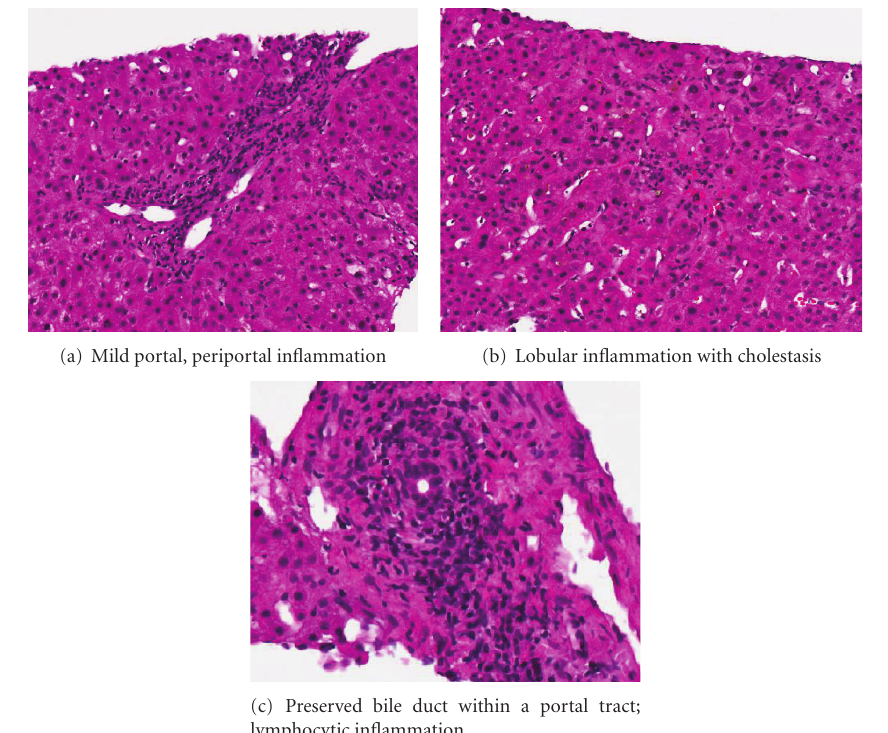
Figure 3: Histomicrograph of liver biopsy in February